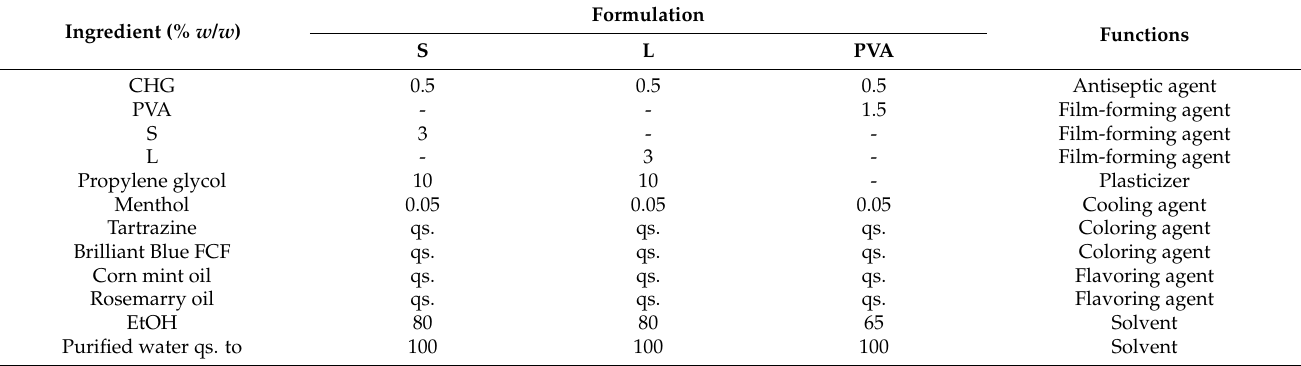
Table 3. Constituent of